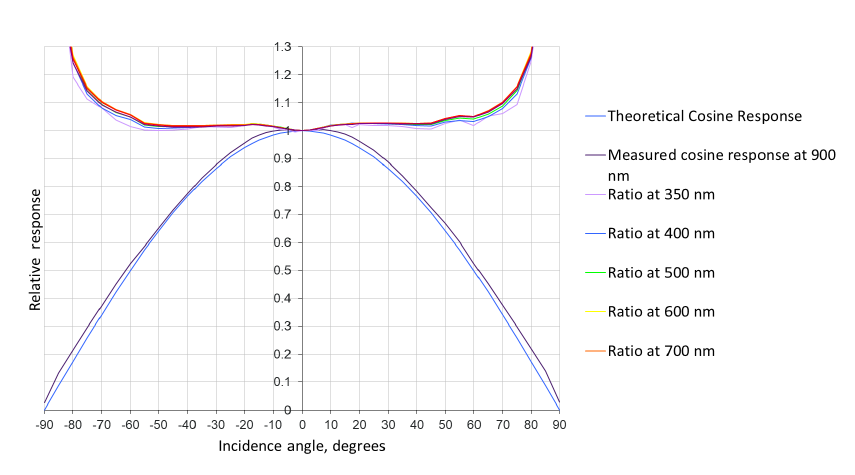
Figure 8. Diffuses cosine response tests results. Series marked as ratio at particular wavelength are the ratios of the measured instrument response to the theoretical cosine response for a given angle and normalised to 0